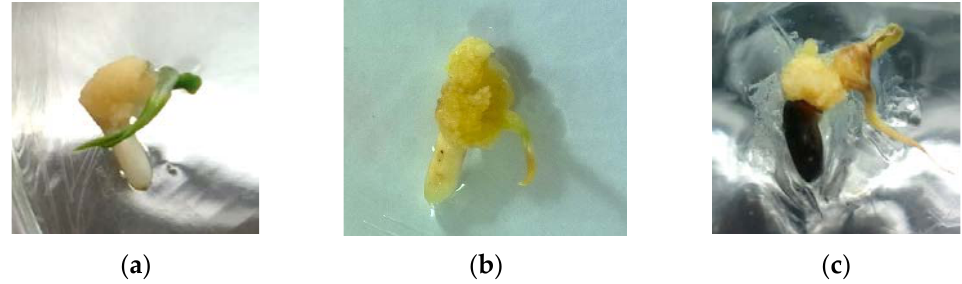
Figure 2. Callus derived from seed of Hommali ( a ), Munpu ( b ), and Niawdum ( c )